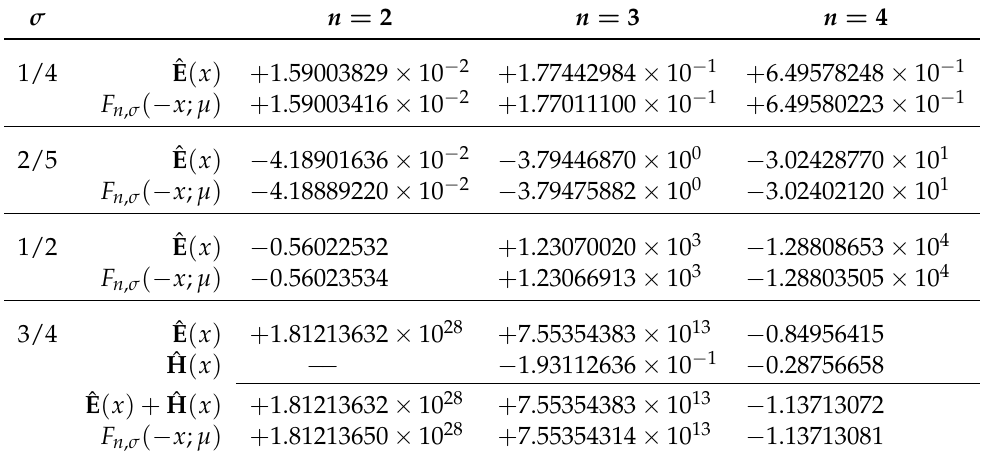
Table 2. The values of the exponential and algebraic expansions compared with F n , σ ( x ; µ ) for large x < 0 for different values of σ and n when µ = 3/4 and σ = 3/4).